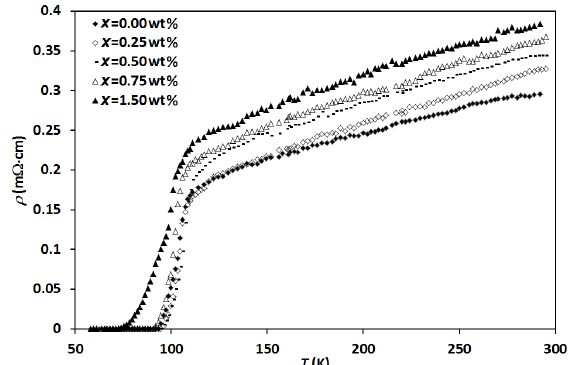
Fig. 4 Plots of electrical resistivity versus temperature for (BaSnO 3 ) x /BiPb-2223 samples.